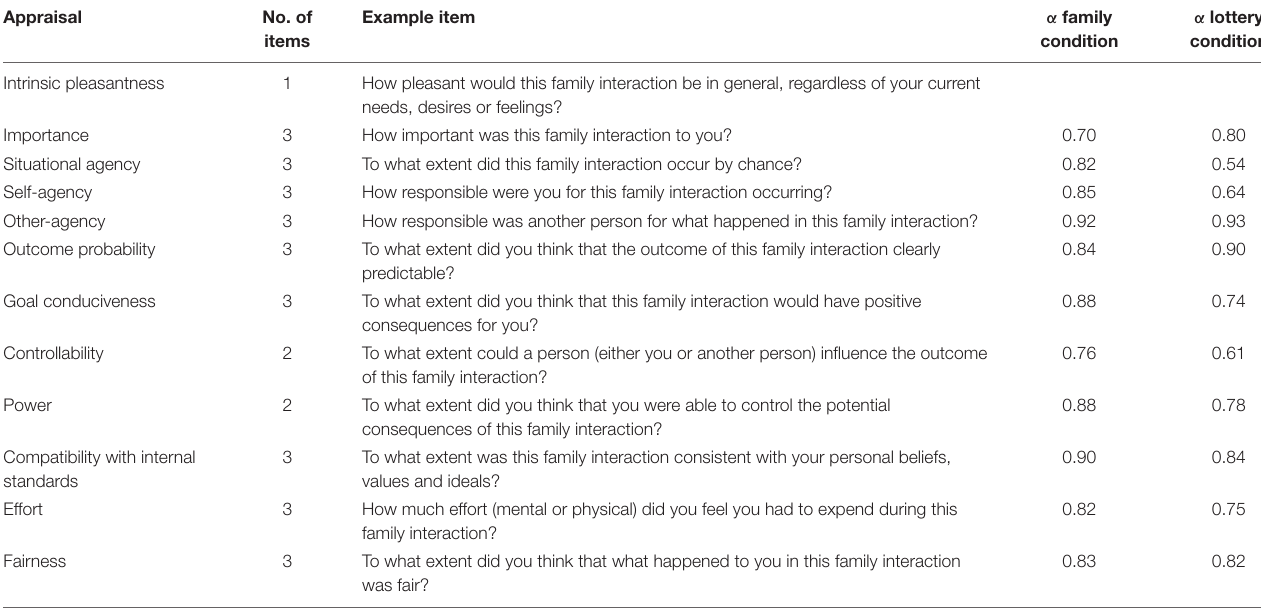
TABLE 1 | Reliabilities and example items of the appraisal scales.